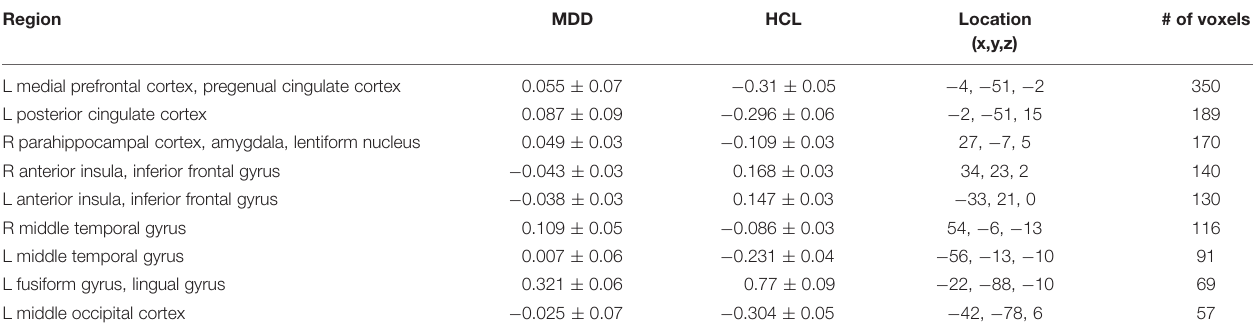
FIGURE 4 | Group differences in brain activation during the facial emotion identification task. All regions shown here are corrected for multiple comparisons at a cluster-wise threshold of p < 0.05 (see Materials and Methods for more details). Locations are reported in Montreal Neurological coordinates (radiological convention). TABLE 2 | Summary of location and size of brain regions showing significant group differences on facial emotion identification